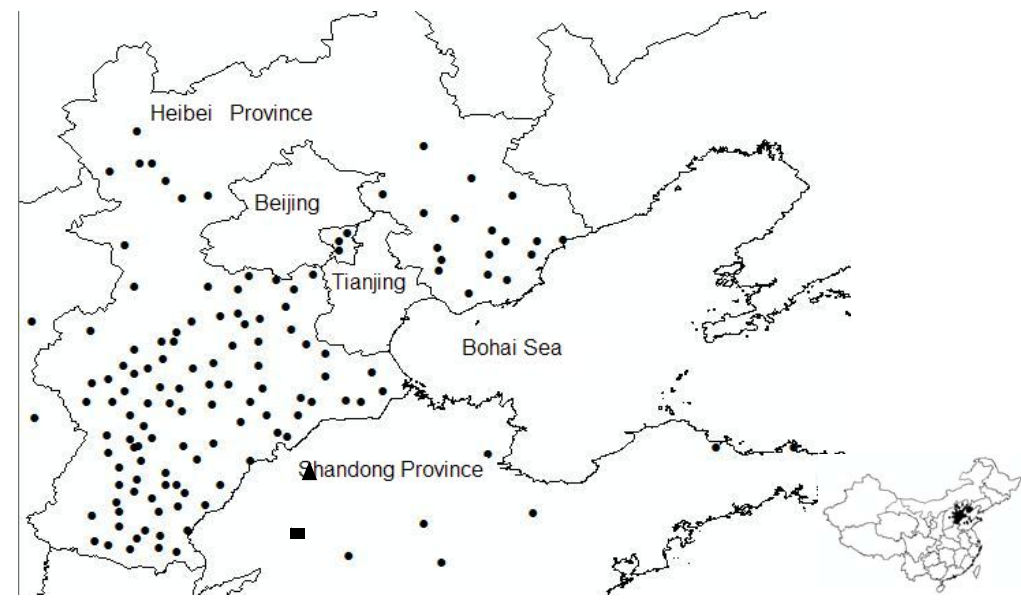
Figure 3. Spatial distribution of standard meteorological stations in the study